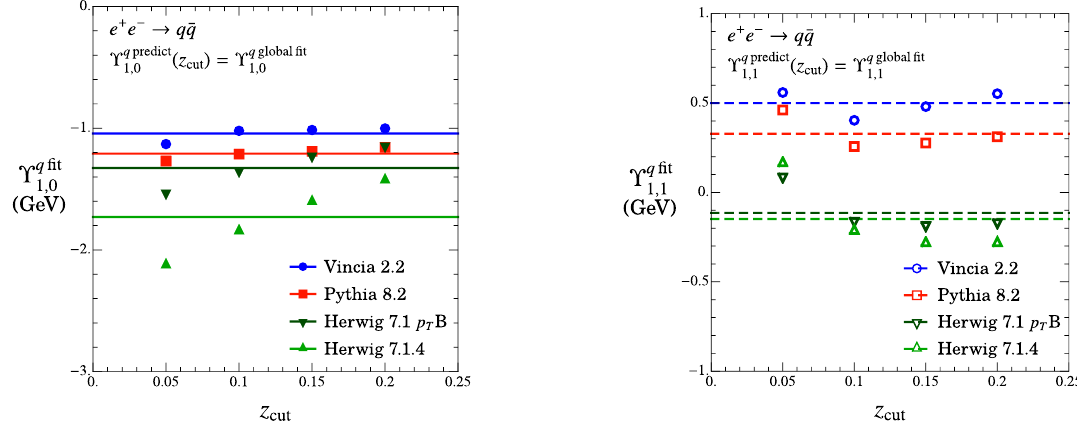
Figure 24 . Testing z cut independence of (cid:7) q comparing against the global